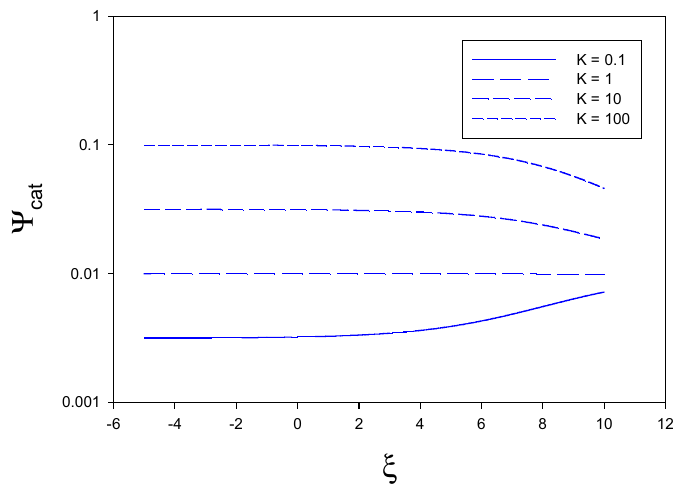
Figure 3. Variation of catalytic efficiency with normalized potential for heterogeneous redox catalysis via the bimolecular mechanism for the case of slow generation of mediator